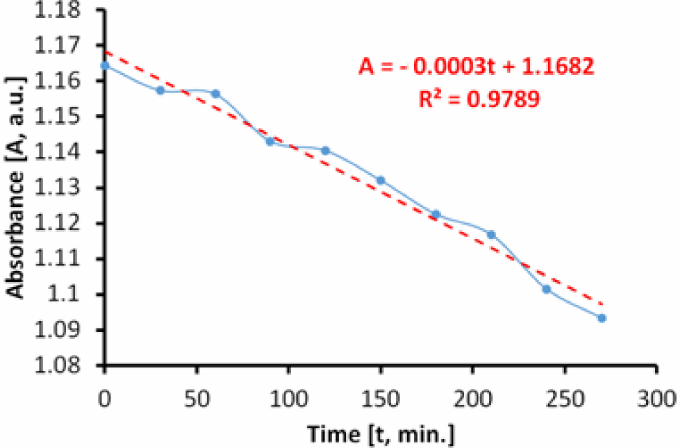
Figure 13. Time variation of MB solution absorbance by irradiating with light from the near ultraviolet range (300–400 nm) in the absence of the photocatalytic